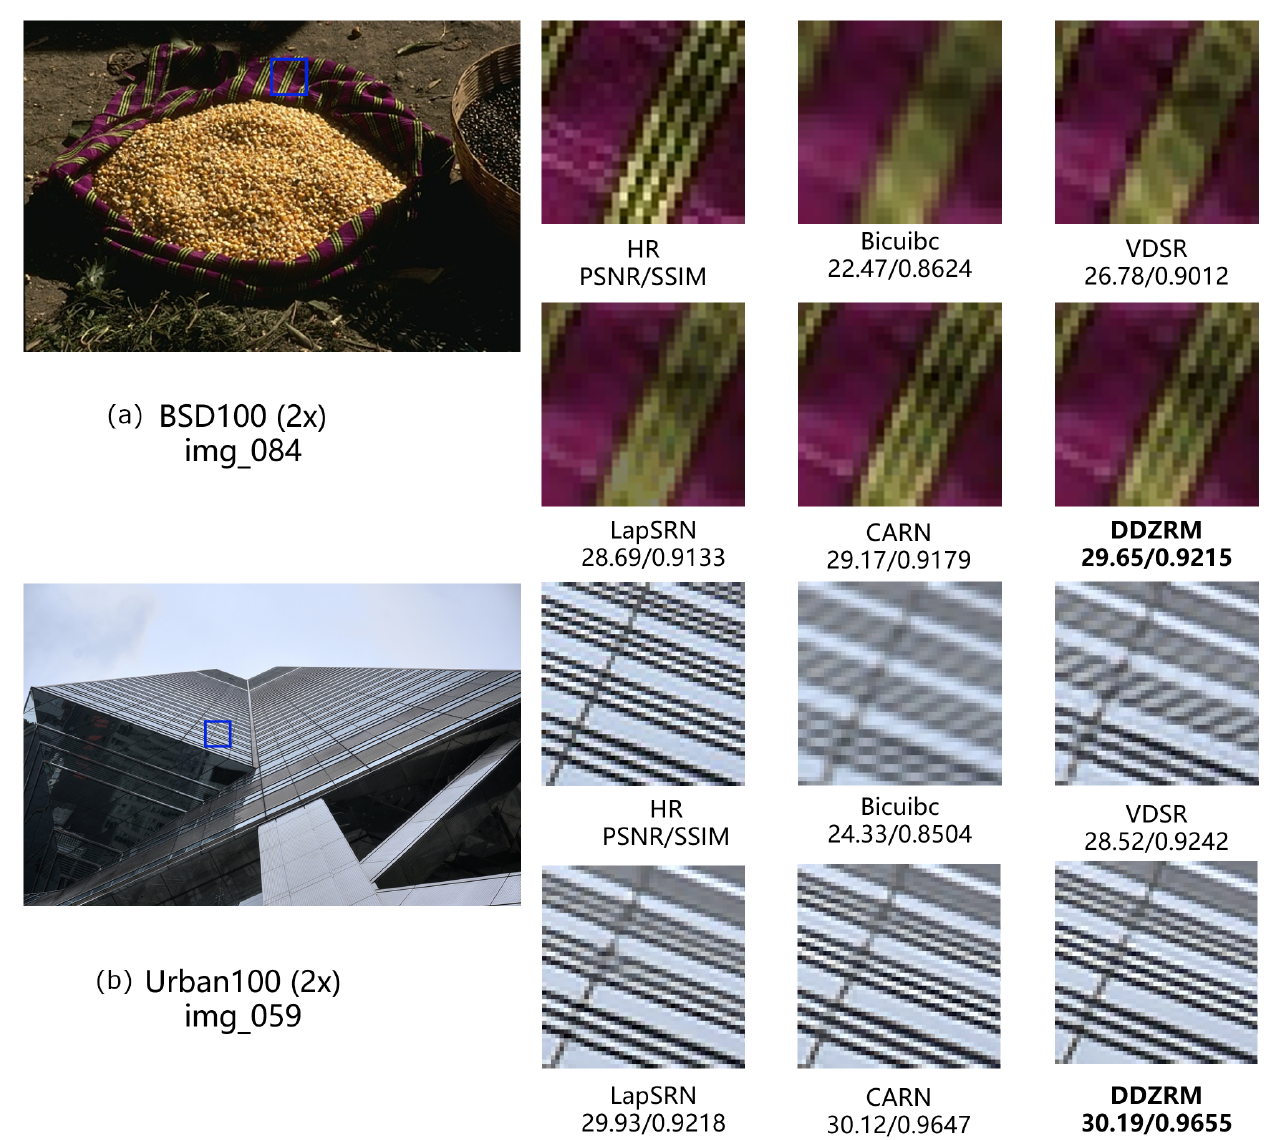
Figure 10. ( a ) Comparison of the performance of DDZMR networks and the state-of-the-art networks on dataset B100 [34]; ( b ) Comparison of the performance of DDZMR networks and the state-of-the-art networks on dataset Urban100